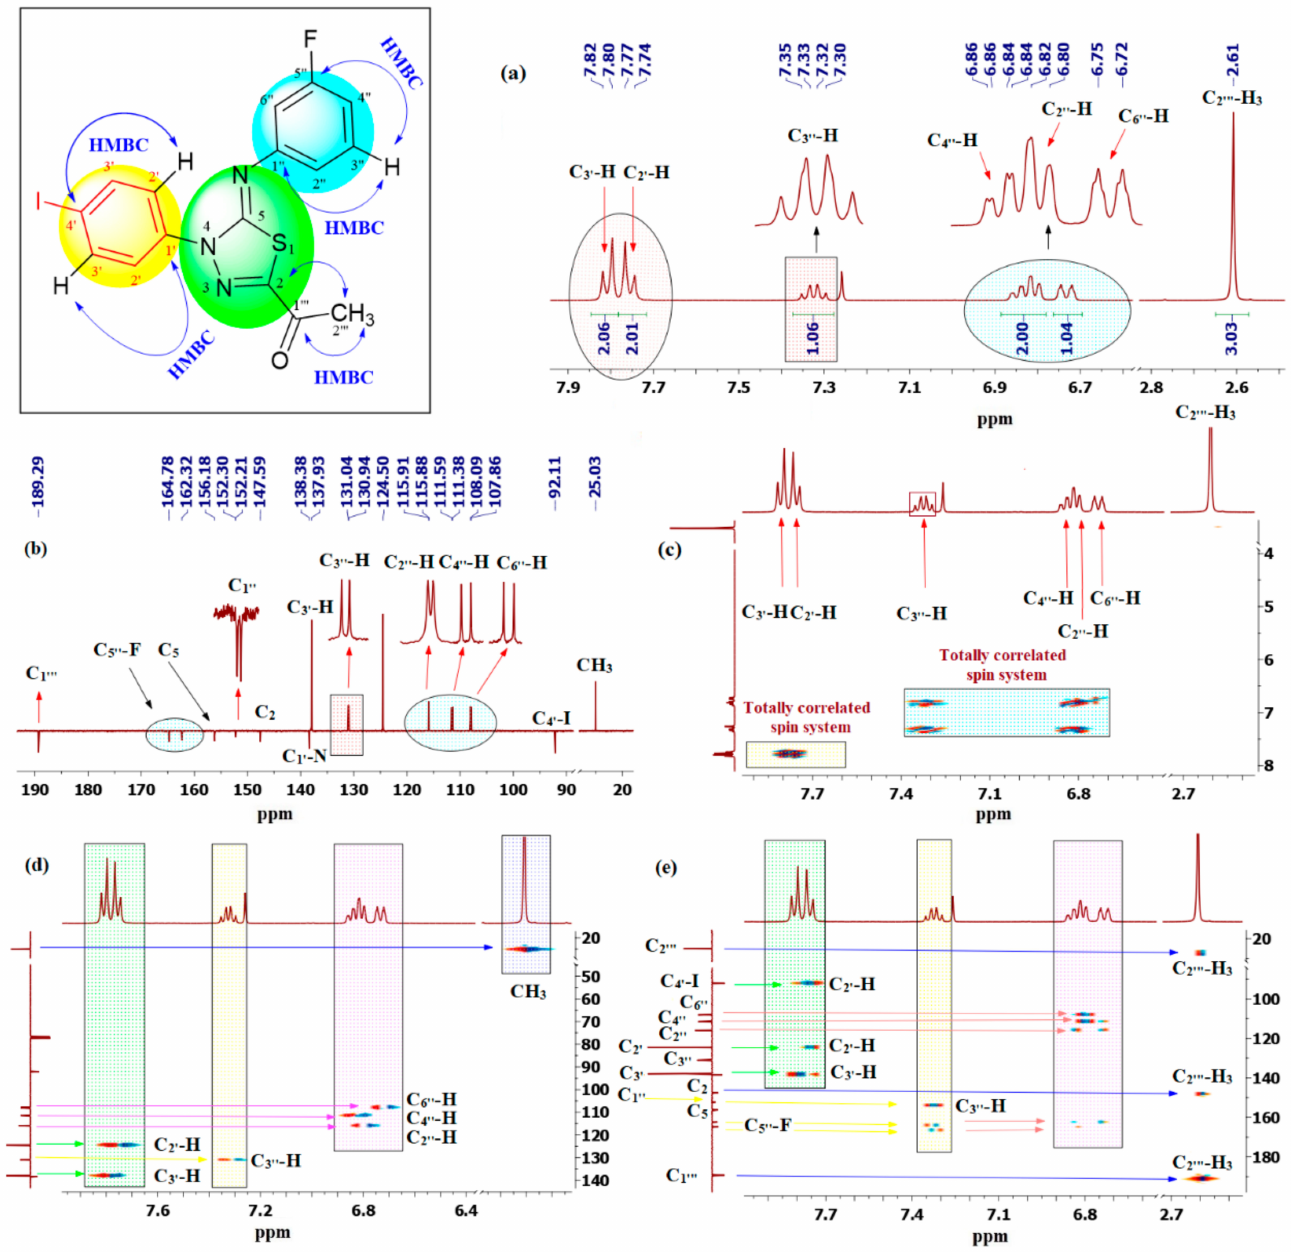
Figure 5. Truncated 1D and 2D NMR spectra of 1,3,4-thiadiazole 58 : ( a ) 1 H-NMR; ( b ) 13 C-CRAPT NMR; ( c ) 1 H- 1 H-gDQFCOSY NMR; ( d ) 1 H- 13 C-gHSQC NMR; ( e ) 1 H- 13 C-gHMBC